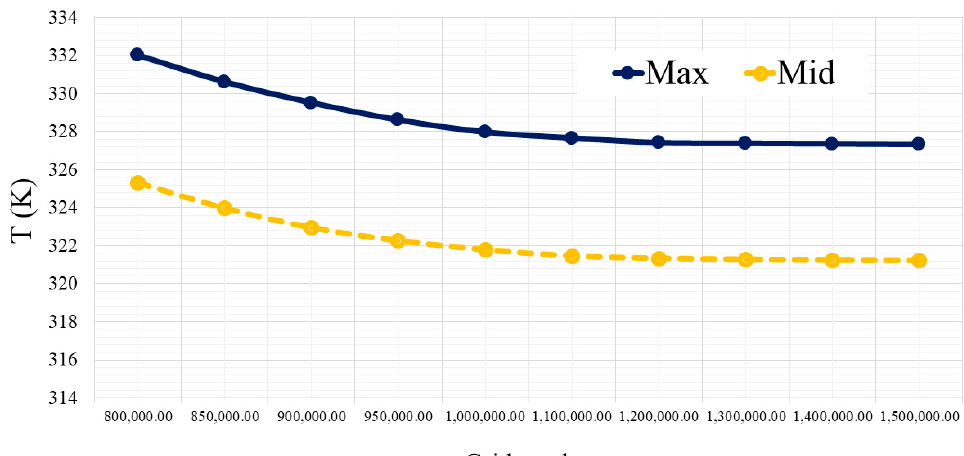
Figure 2. Grid independency study comparing the output temperature of the WMCHS based on the number of grids.